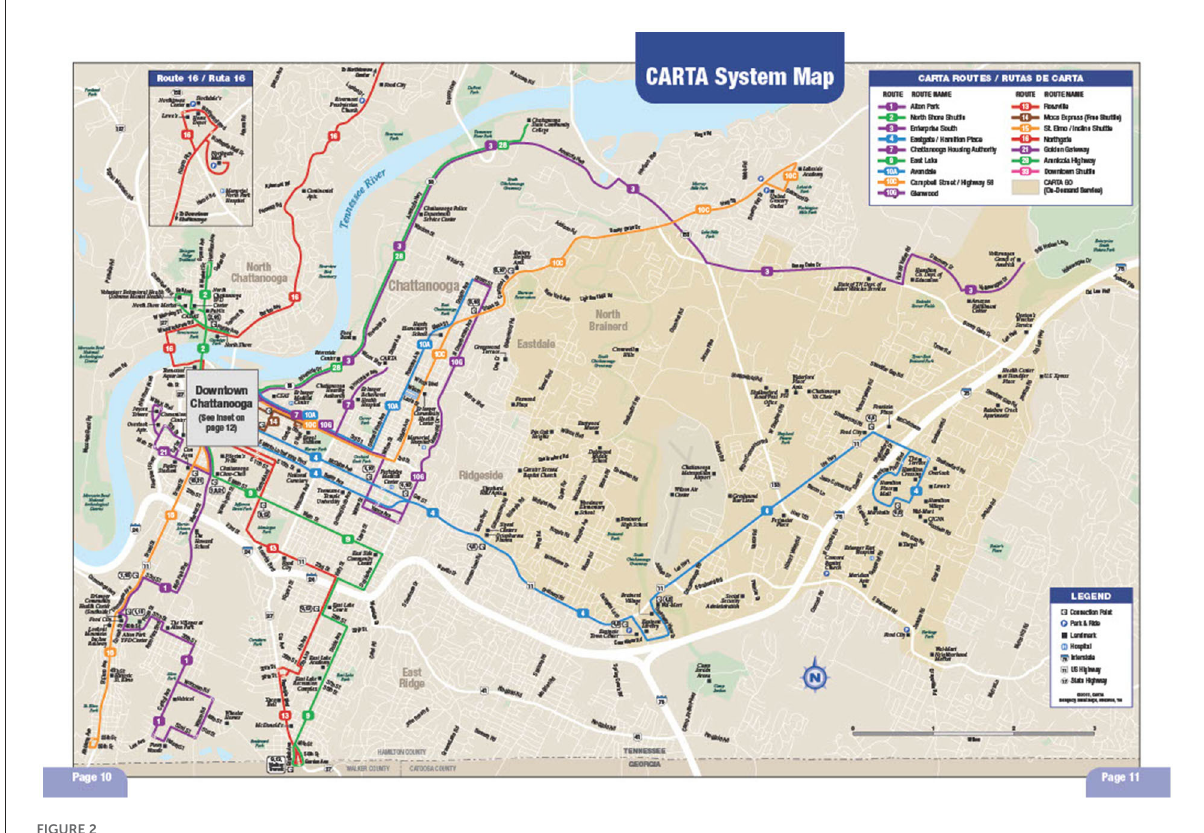
FIGURE2 CARTA system